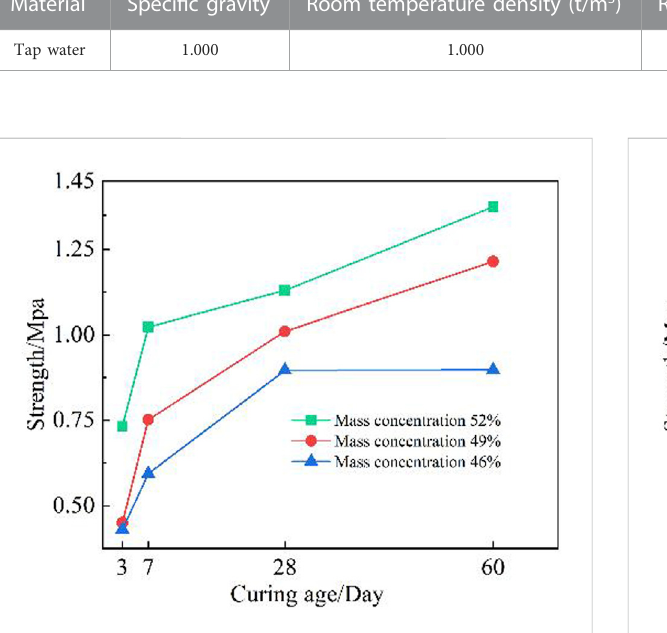
FIGURE 3 Variation of the strength of back fi ll materials with age for ash- tailings ratio 1:6.